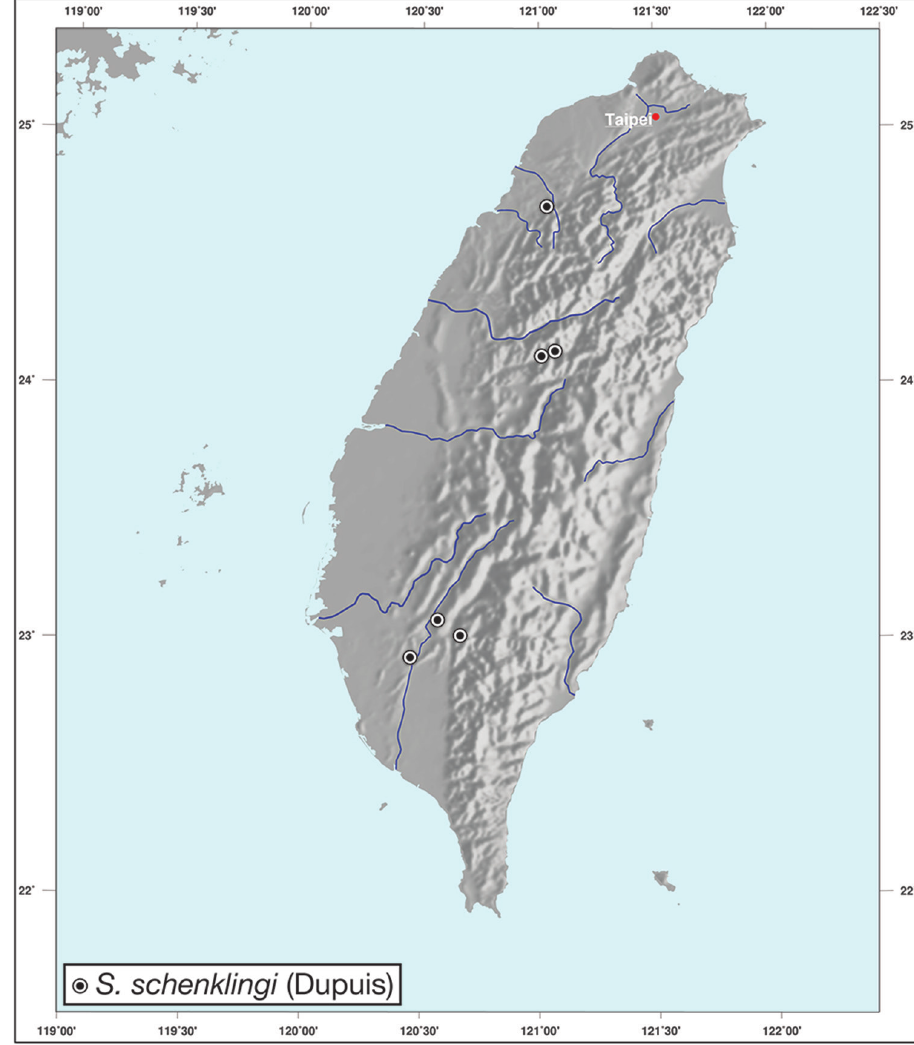
Figure 109. Map showing known localities for species of the genus Serrimargo Chaudoir, in Taiwan.